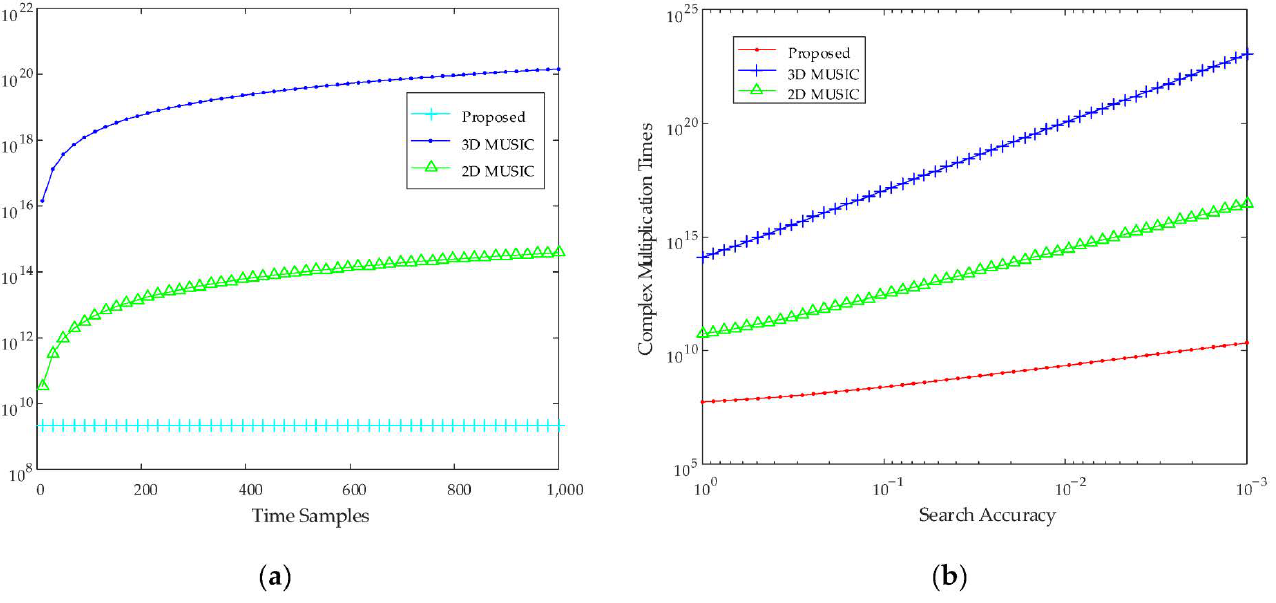
Figure 9. The comparison results of complexity. ( a ) the relationship between the complexity and the number of time samples when the search precision is 0.01. ( b ) the relationship between the complexity and the search precision when the number of time sample is 750.